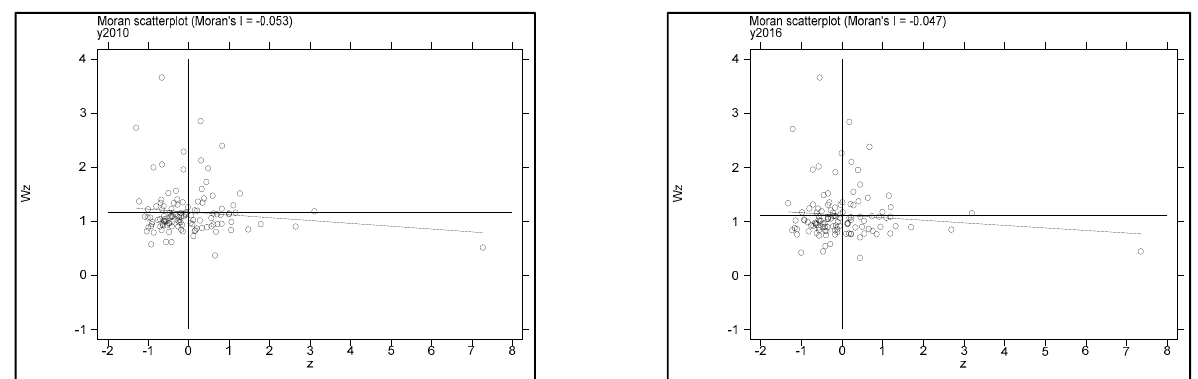
Figure 9. Moran’s I scatter diagram of arable land investment potential of countries along “the belt and road initiative”.